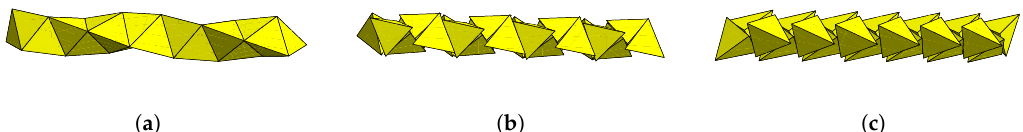
Figure 1. Canonical and modified Boerdijk–Coxeter helices: ( a ) a right-handed Boerdijk-Coxeter (BC) helix; ( b ) a “5-BC helix” may be obtained by appending and rotating tetrahedra through the angle given by Equation (4) using the same chirality of the underlying helix; ( c ) a “3-BC helix” may be obtained by appending and rotating tetrahedra through the angle given by Equation (4) using the opposite chirality of the underlying helix.